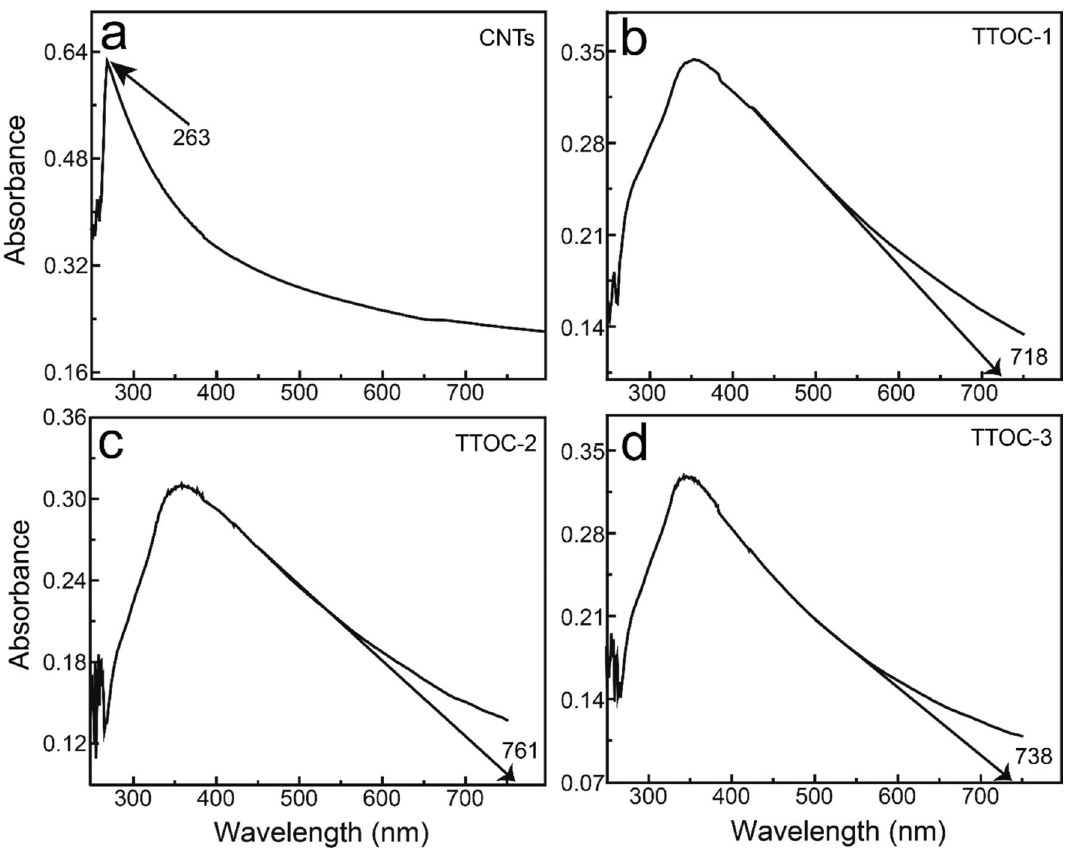
Figure 5. UV–vis spectra of ( a ) pristine CNTs and ( b ) TTOC-1, ( c ) TTOC-2, and ( d ) TTOC-3 nanocomposites.